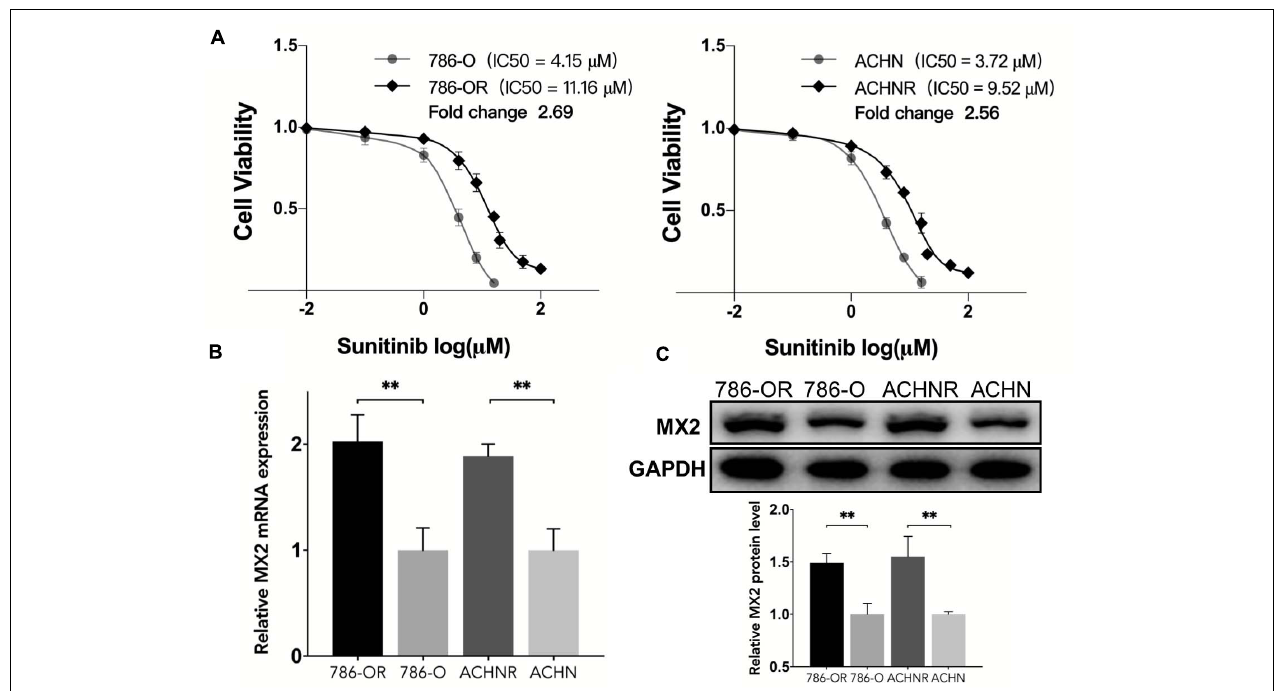
FIGURE 7 | Upregulation of MX2 expression in sunitinib-resistant cell lines. (A) CCK8 assay indicated the formation of sunitinib resistance in 786-O and ACHN cells. (B) Relative mRNA expression of MX2 by qPCR. (C) Relative protein expression of MX2 by Western blotting. The error bars represent mean ± SD. Data differences were tested with Student’s t -test ( ∗∗ p < 0.01).